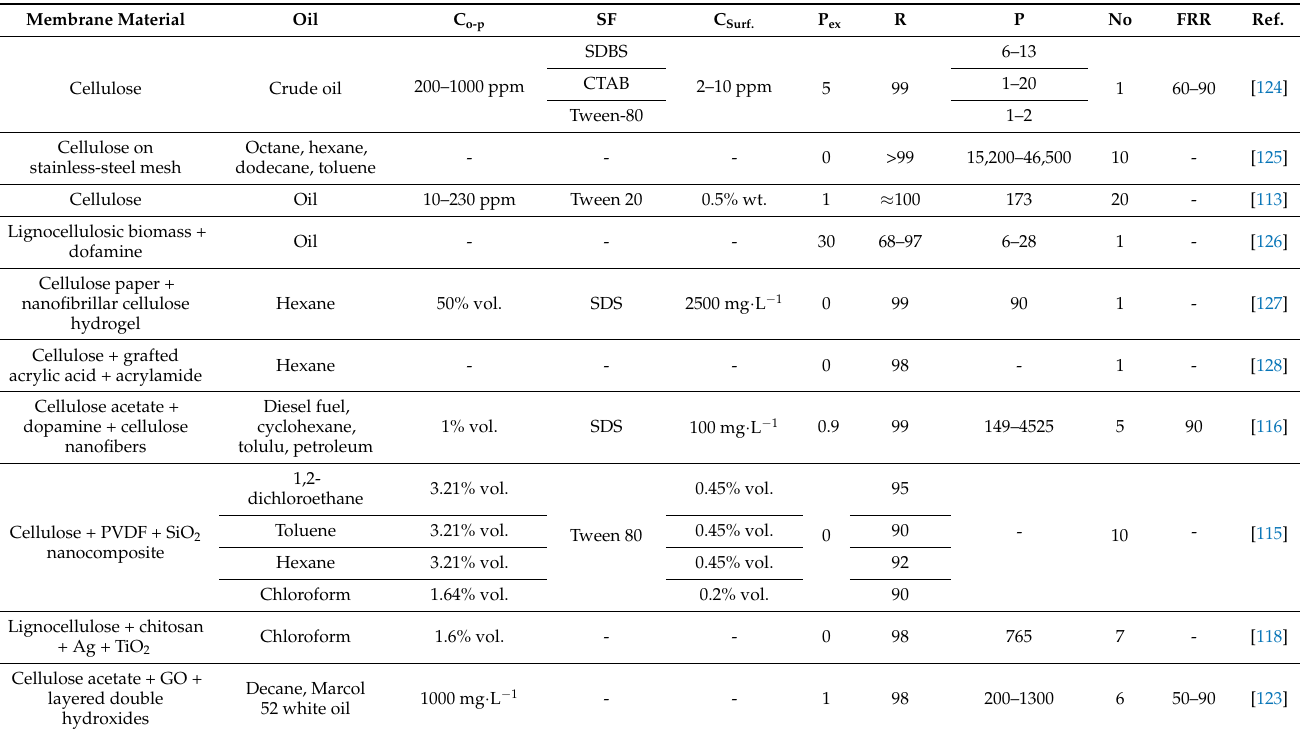
Table 7. Membranes based on natural polymers and their derivatives for the separation of oil-in- water